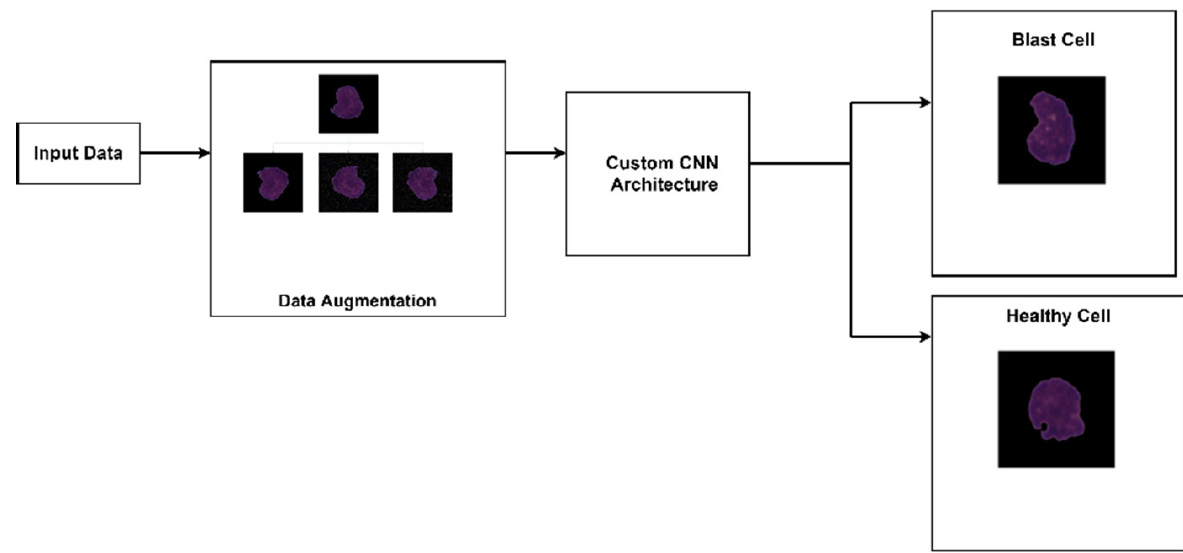
Figure 1. Leukemia screening system.